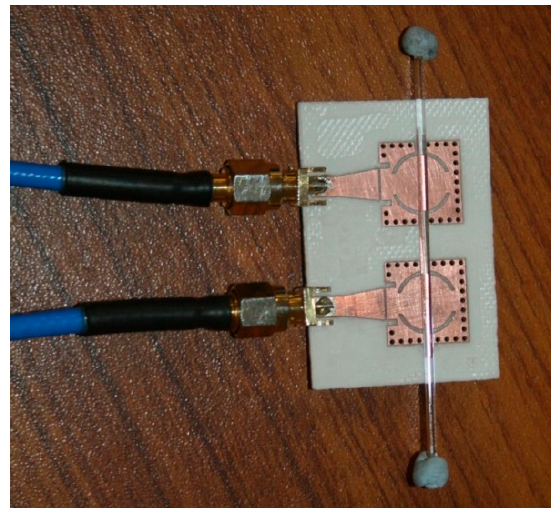
Figure 5. Horizontal placement of the LUT on the SIW filter.